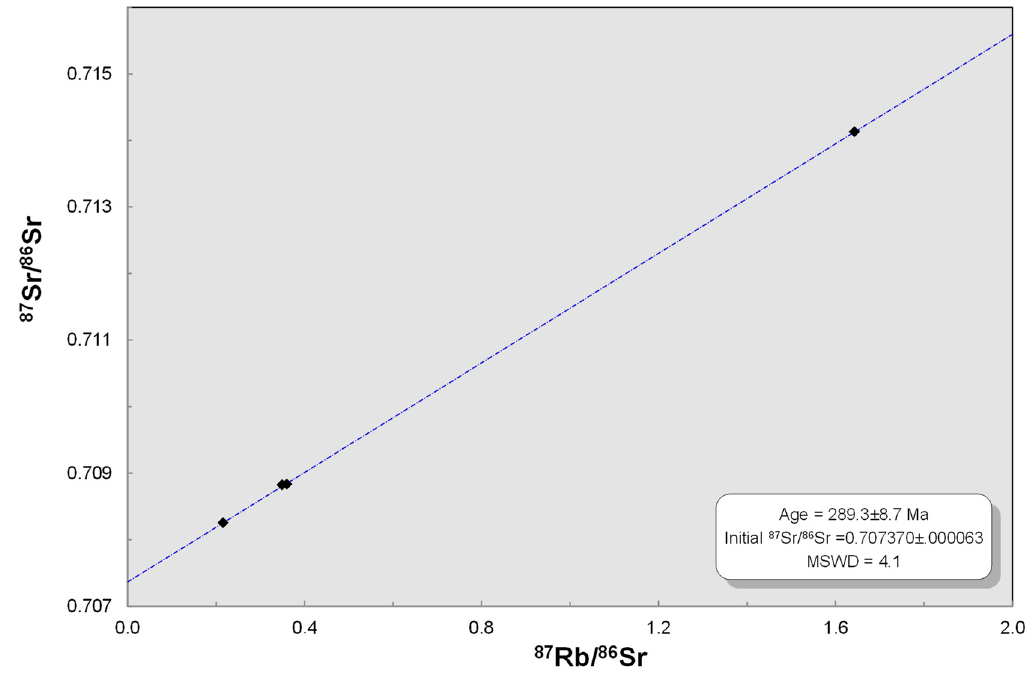
Figure 12. The Rb-Sr isochrone for three sapphire-bearing rocks and one muscovite samples associated with sapphire of 418 mine in Ilmen Mountains are with yielded age at 289.3 ± 8.7 Ma (2 σ ), MSWD is 4.1.